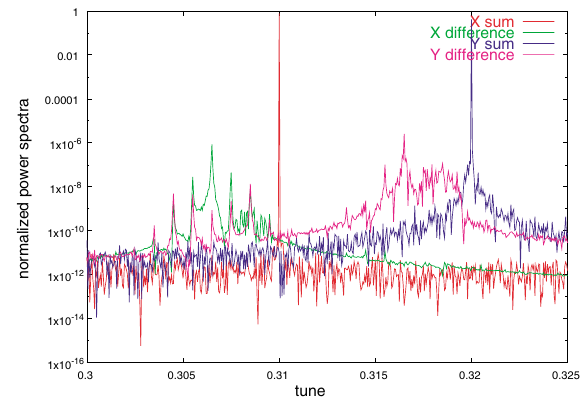
FIG. 7. (Color) The luminosity per collision as a function of turns during the sweeping process.